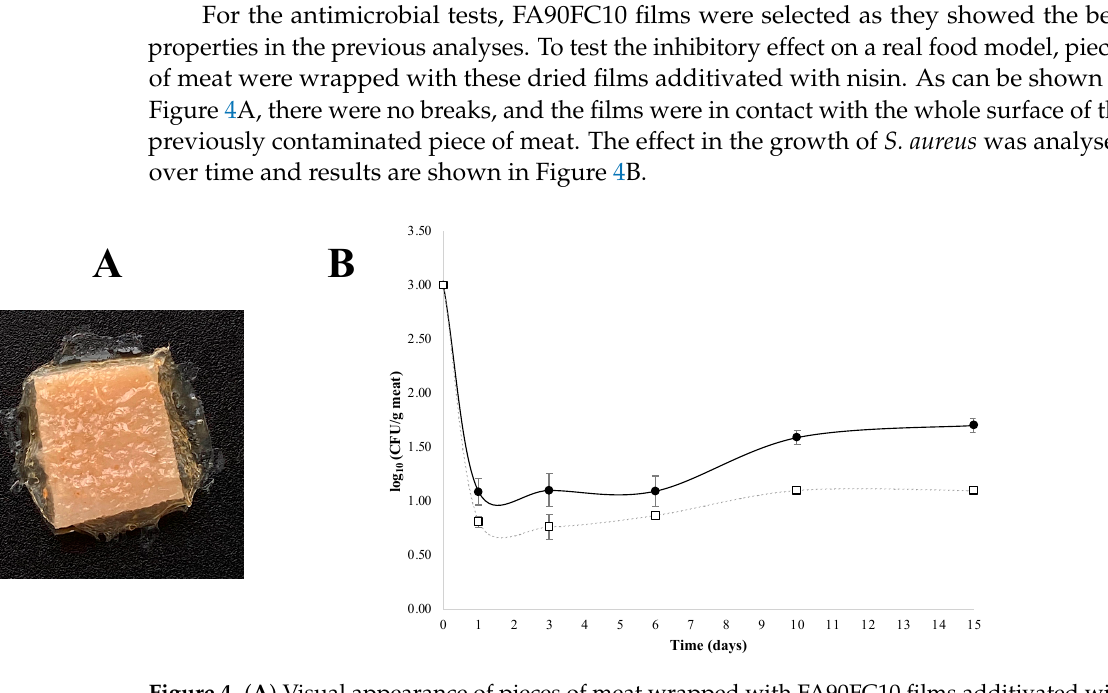
Figure 4. ( A ) Visual appearance of pieces of meat wrapped with FA90FC10 films additivated with nisin. ( B ) Evolution of S. aureus growth in meat for 15 days storage at 4 °C; ( □ ) FA90FC10 films additivated with nisin and ( • ) FA90FC10 control films without nisin. ANOVA and LSD were performed. Significant differences between samples were found from day 6.